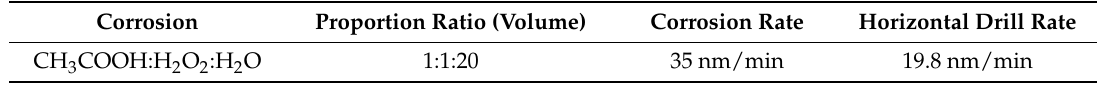
Table 5. Patterned process of metal (copper).